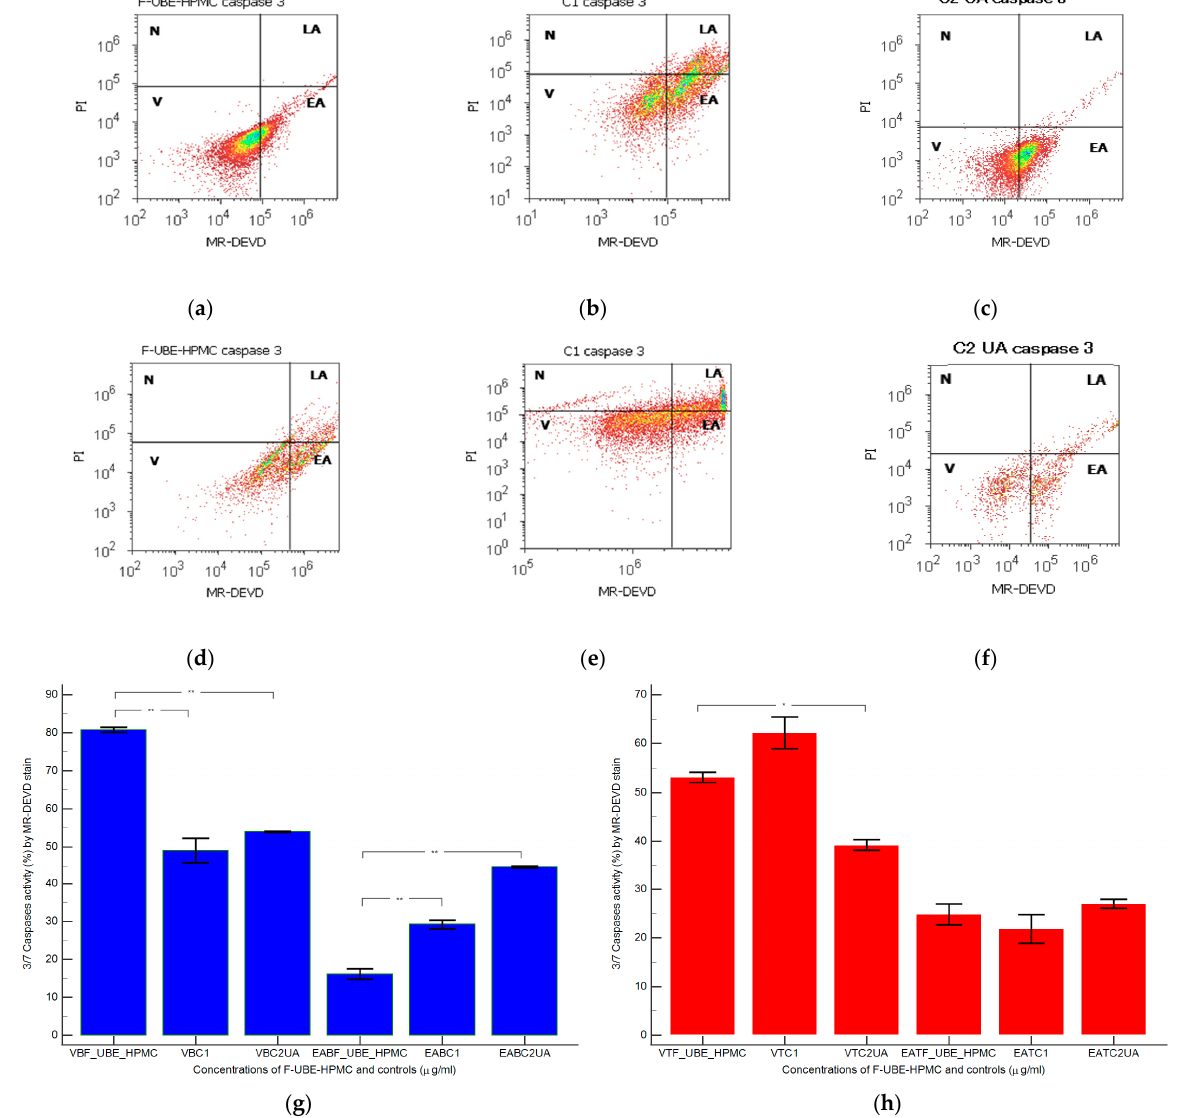
Figure 5. Caspases 3/7 activity models in normal blood cells ( a – c ) and CLS-354 tumor cells ( d – f ) after 24 h treatment with F-UBE-HPMC. MR-DEVD patterns of F-UBE-HPMC ( a , d ), 1% DMSO negative control ( b , e ), and 125 µ g/mL UA-positive control ( c , f ); Statistical analysis of 3/7 caspases activity in normal blood cells ( g ) and CLS-354 tumor cells ( h ). * p < 0.05 and ** p < 0.01 evidence significant statistical differences between controls and F-UBE-HPMC made by paired samples t -test; V—viability; EA—early apoptosis; F-UBE-HPMC—mucoadhesive oral patches loaded with U. barbata (L.) dry ethanol extract; C1—negative control with 1% dimethyl sulfoxide (DMSO); C2UA—positive control with 125 µ g/mL usnic acid